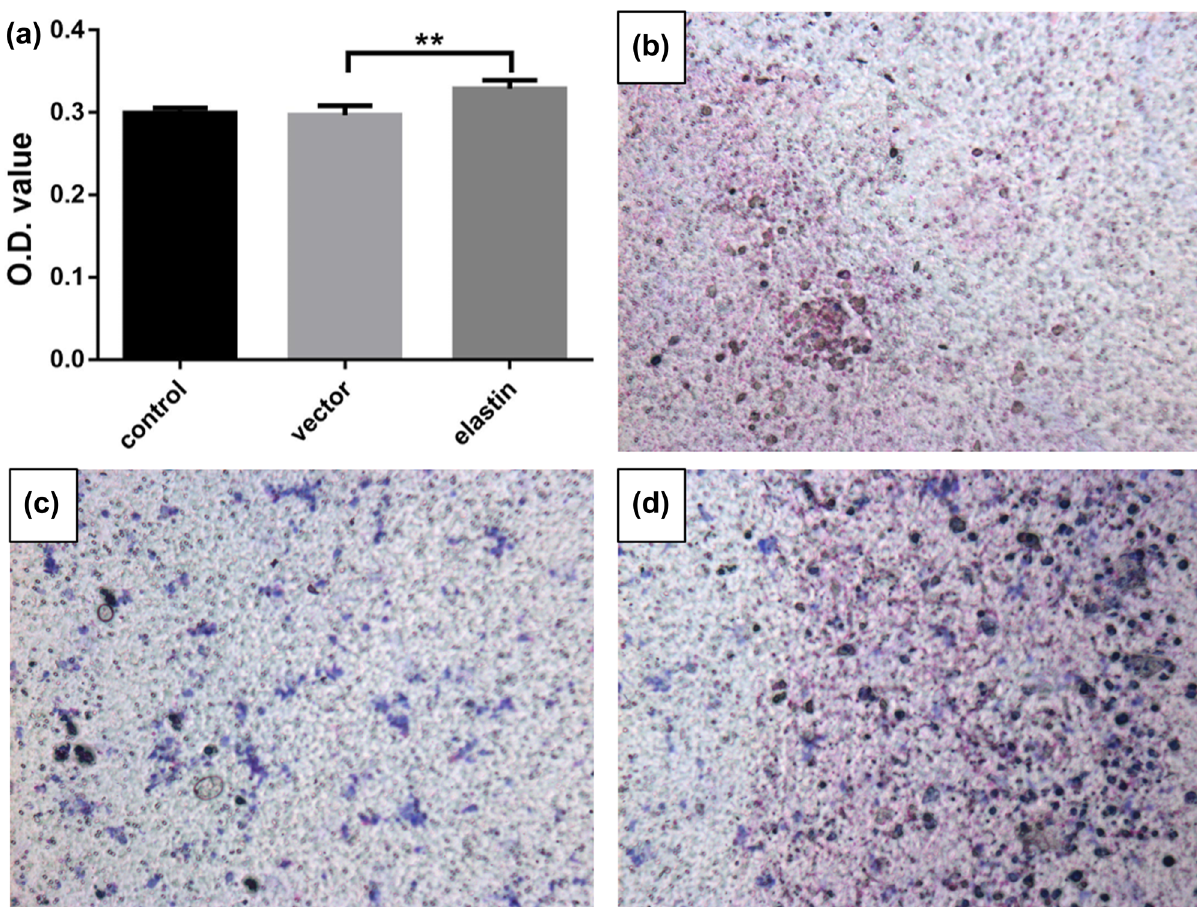
Figure 4: Calculated result of ( a ) cell migration, ( b ) staining images of control, ( c ) empty vector, and ( d ) elastin gene - loaded vector groups (× 100 )